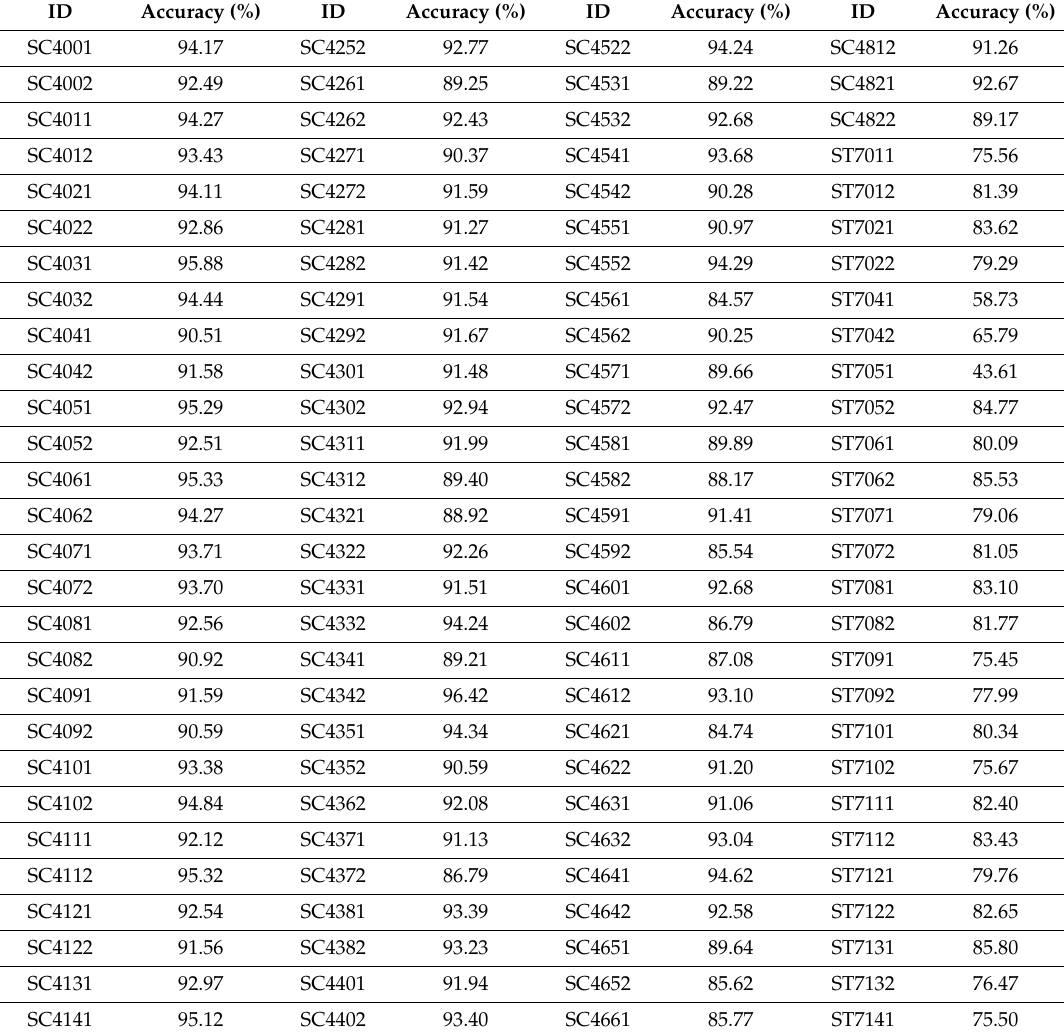
Table 4. Performance of classification for each recording in Sleep-EDF database (version